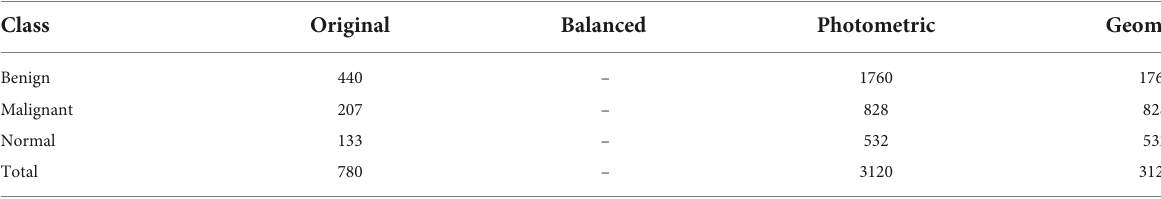
TABLE 2 Description of the original and augmented datasets. Breast ultrasound image